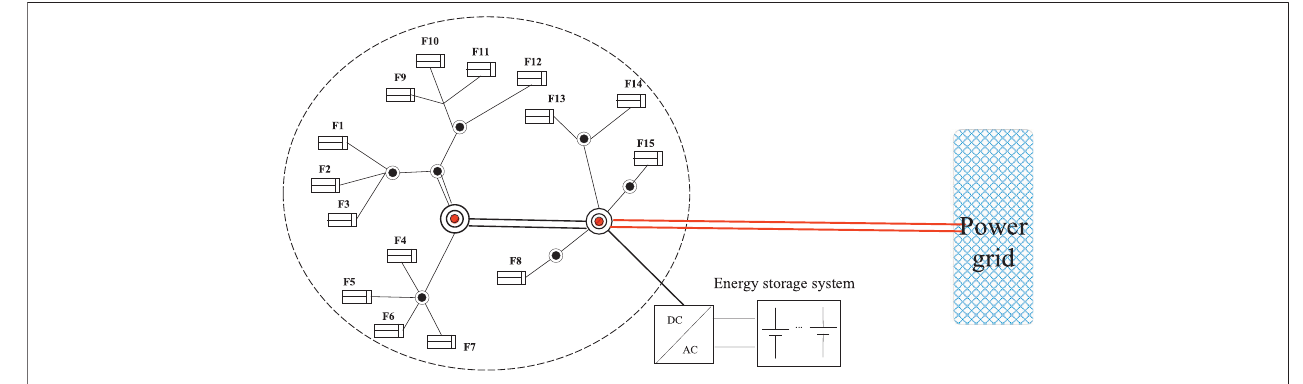
FIGURE 5 | Wind farm cluster centralized grid.